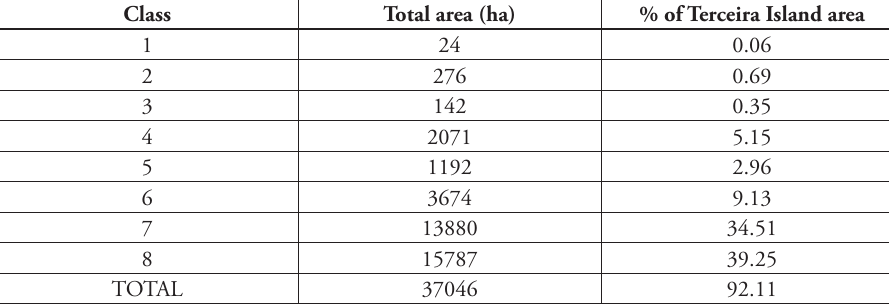
Table 3. Spatial assessment of bees’ richness classes in Terceira Island.